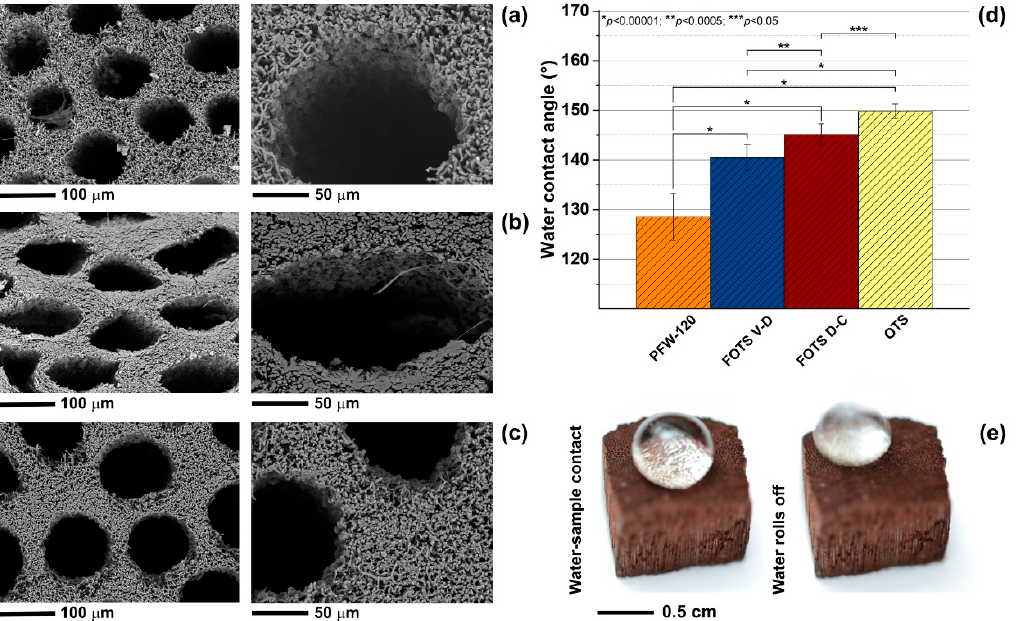
Figure 3. SEM images, with two different magnifications, of the surface porosity of G. applanatum samples treated with ( a ) FOTS by vapour deposition, ( b ) FOTS by dip-coating and ( c ) OTS by dip-coating. ( d ) Water contact angle values of the treated samples. ( e ) Photographs of one water drop impacting on the surface of the OTS-treated sample.